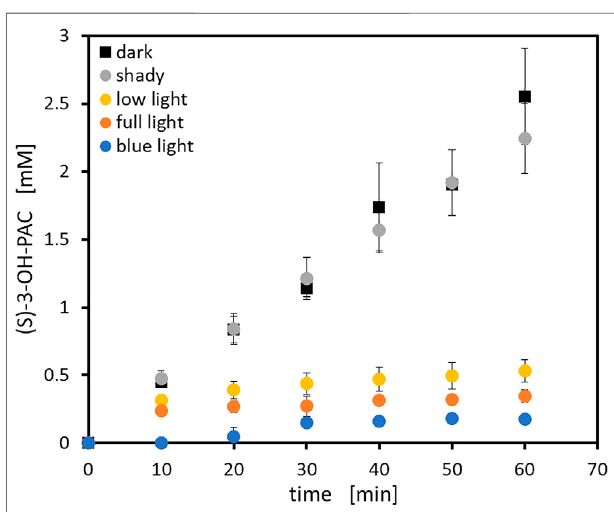
FIGURE 7 | Activity test of SOPP3- Ap PDC-EGWH (0.5 mg ml − 1 ; puri fi ed and lyophilized) at different light conditions (details are given in Table2 )and 60 minofexposure time.Generalreactionconditions: 40 mM3- hydroxybenzaldehyde, 200 mM pyruvate (sodium salt) and 50 mM